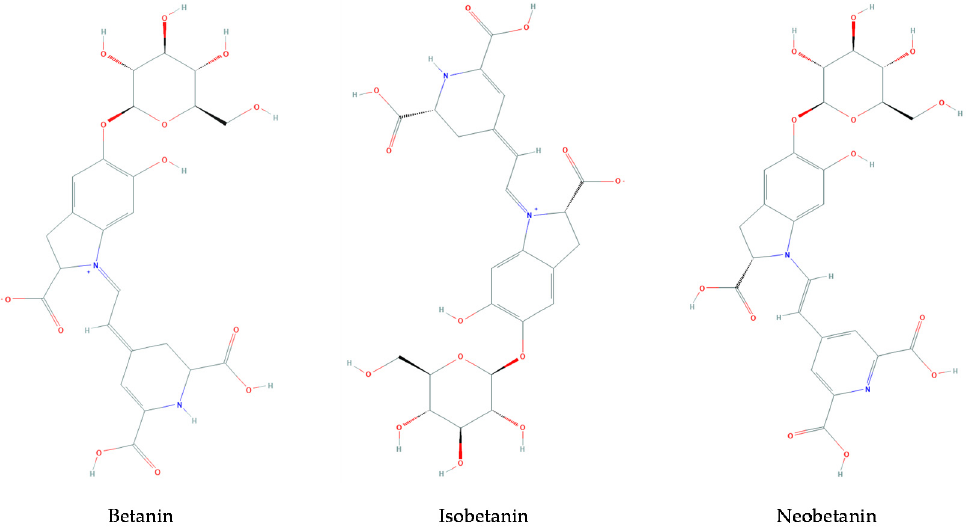
Figure 2. Chemical structure of the three main beetroot betacyanins.